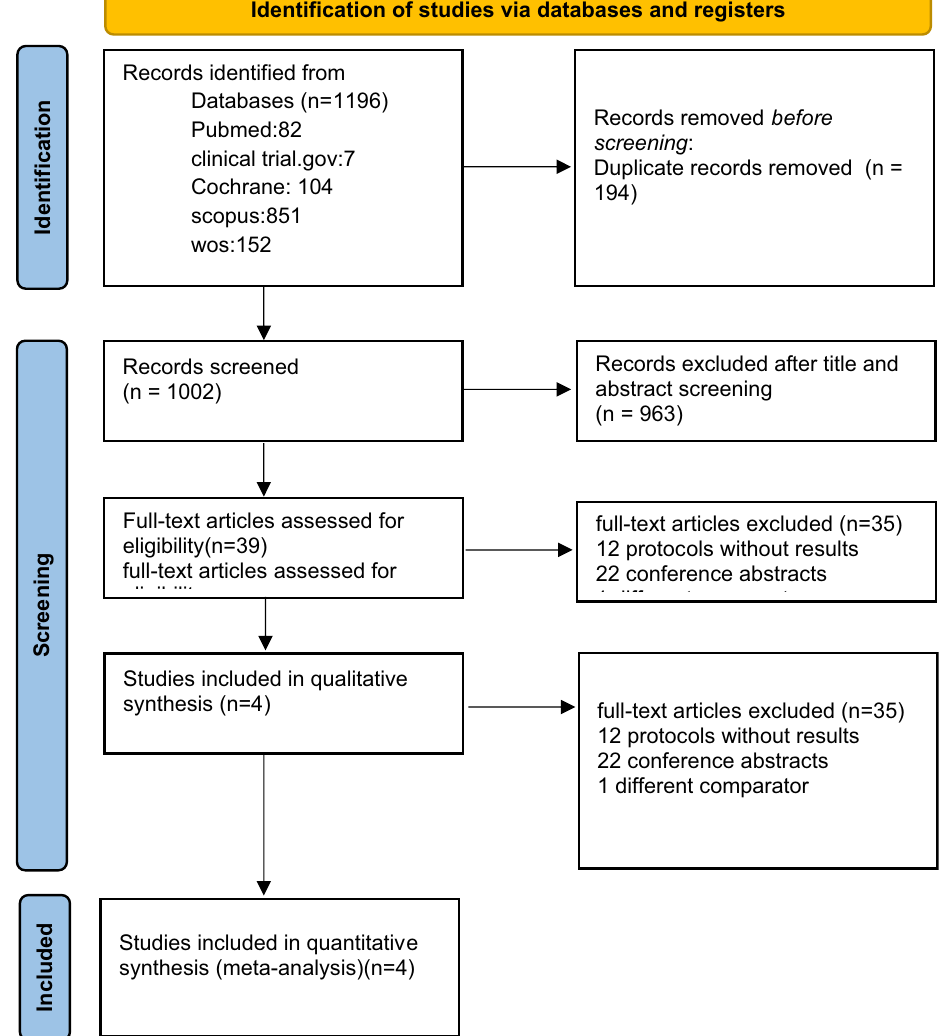
Figure 1. Preferred reporting items for systematic reviews and meta-analyses (PRISMA). From reference 17 . For more information, visit: http:// www. prisma- state ment.